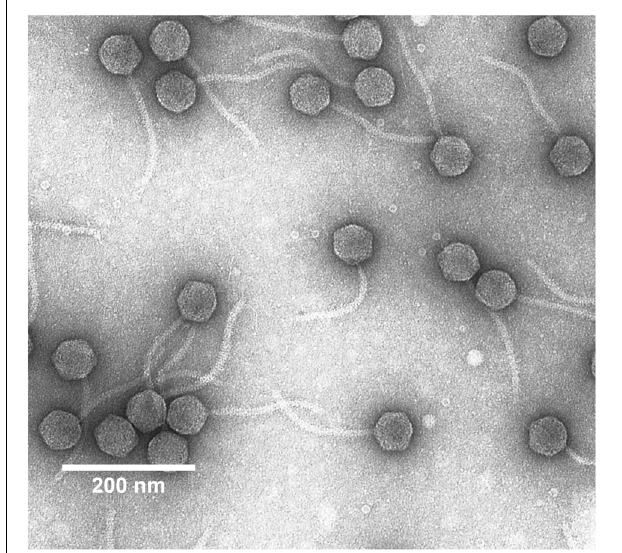
FIGURE 1 | Transmission electron micrograph of Erwinia persicina bacteriophage Midgardsormr38 stained with 0.5% uranyl